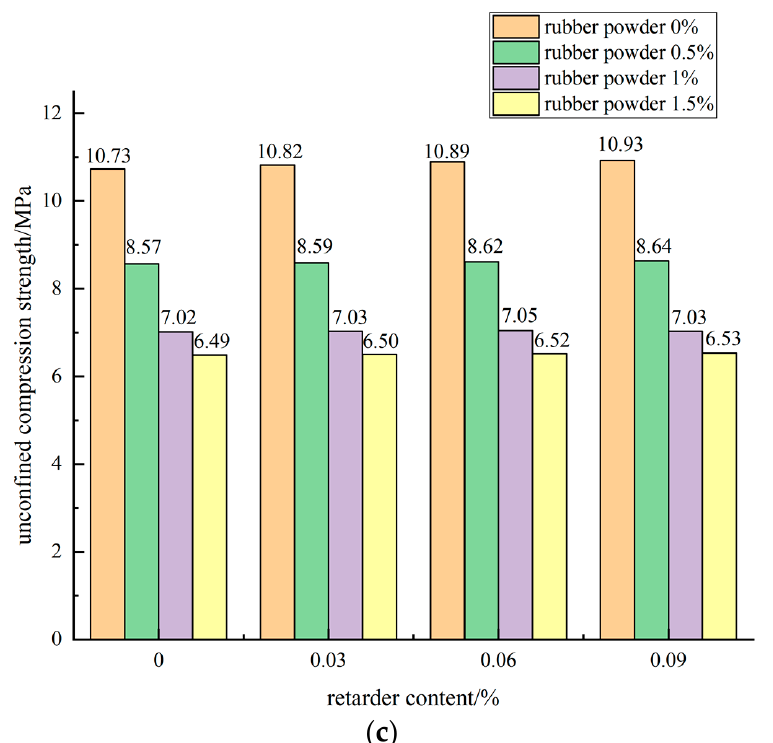
Figure 12. The influence curve of retarder content on the unconfined compressive strength of 7 days ( a ), 28 days ( b ), and 90 days ( c ).